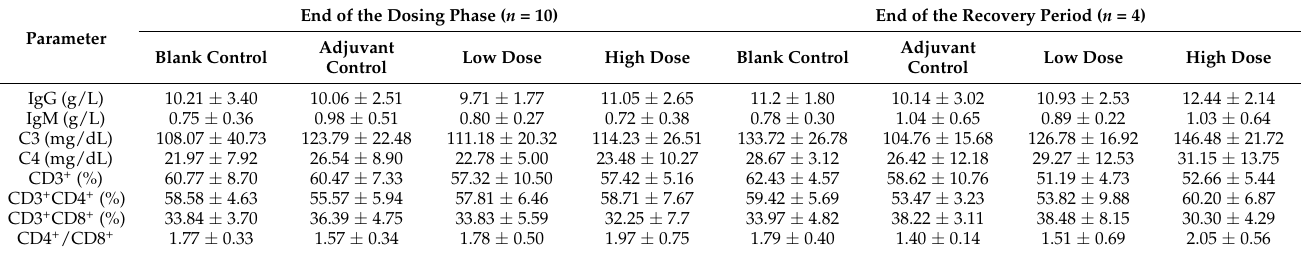
Table 3. The complement C3, C4 and percentage of CD3+, CD4+, CD8+ lymphocytes in cynomolgus macaques treated with ZF001 vaccines in repeat-dose toxicity